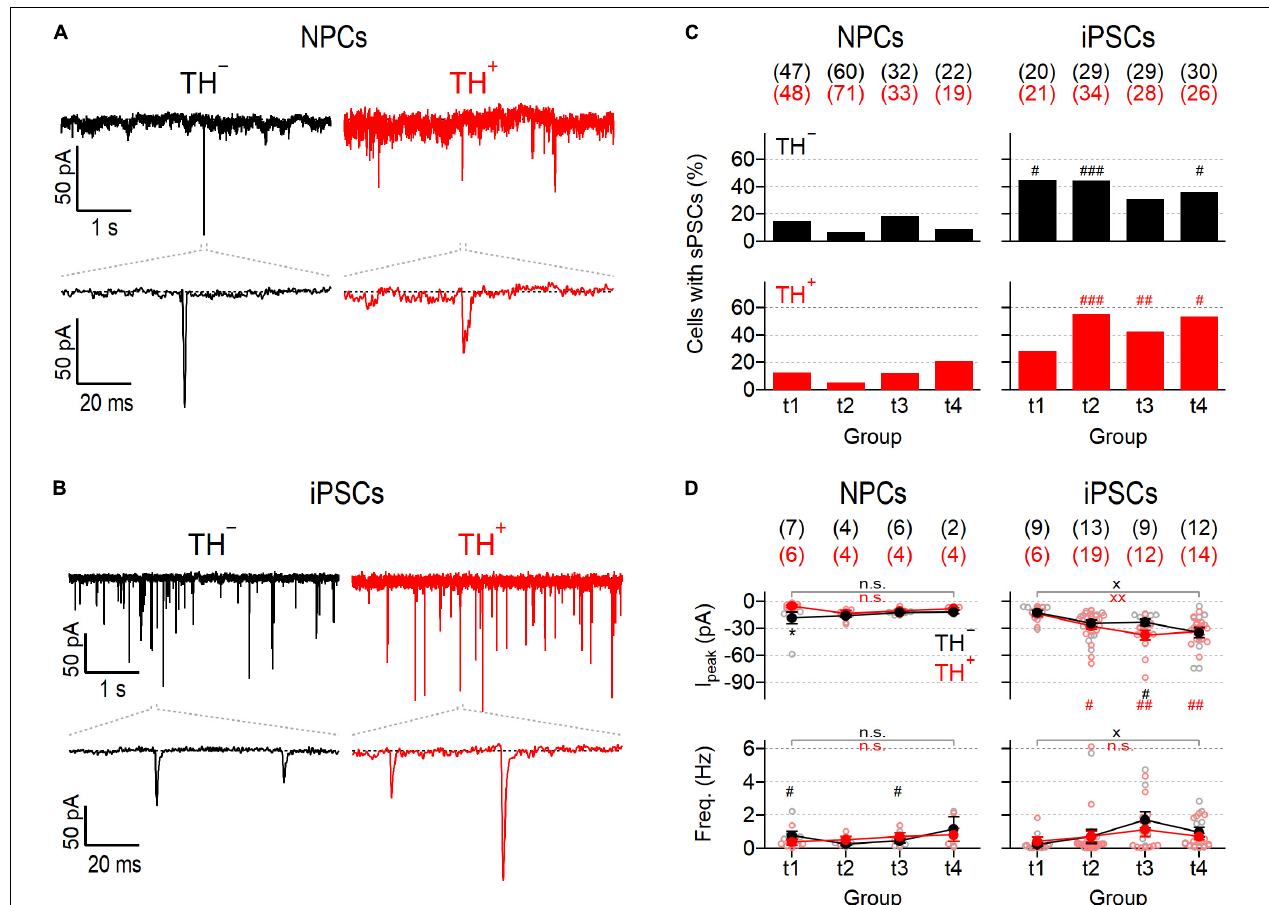
FIGURE 3 | Different synaptic activity in NPC- and iPSC-derived dopaminergic reporter cultures. (A) Representative post-synaptic current responses (PSCs) at time point 2 (t2) from TH − ( left ) and TH + ( right ) NPC-derived neurons at a membrane potential of –77 mV. Bottom traces are enlarged views (100 ms) of the regions specified with dashed lines. (B) Identical recordings as in (A) , obtained from TH − ( left ) and TH + ( right ) iPSC-derived neurons at t2. (C) Bar graphs showing percentages of NPC- ( left ) and iPSC-derived ( right ) TH − ( top, black) and TH + ( bottom, red) neurons that showed PSCs as shown in (A,B) , analyzed at the specified time points (t1–4). Statistic indicators refer to Fisher’s exact test performed for each time point between data obtained from NPC- and iPSC-derived neurons: ### P < 0.001, ## P < 0.01, # P < 0.05. (D) Mean peak current amplitudes ( top ) and frequencies ( bottom ) of PSCs, obtained from NPC- ( left ) or iPSC-derived ( right ) TH − or TH + neurons at different time points during maturation. Filled circles are means ± s.e.m. with the numbers of experimental replicates, n , indicated in parentheses. Straight lines connect means for clarity. Individual data points are shown as open circles. Statistical significance between data pairs was analyzed with a two-tailed Mann–Whitney U -test: * P < 0.05 for testing TH − against TH + of the same line; xx P < 0.01, x P < 0.05 for comparing data obtained at t1 with data obtained at t4; ## P < 0.01, # P < 0.05 for testing data derived from iPSCs against data derived from